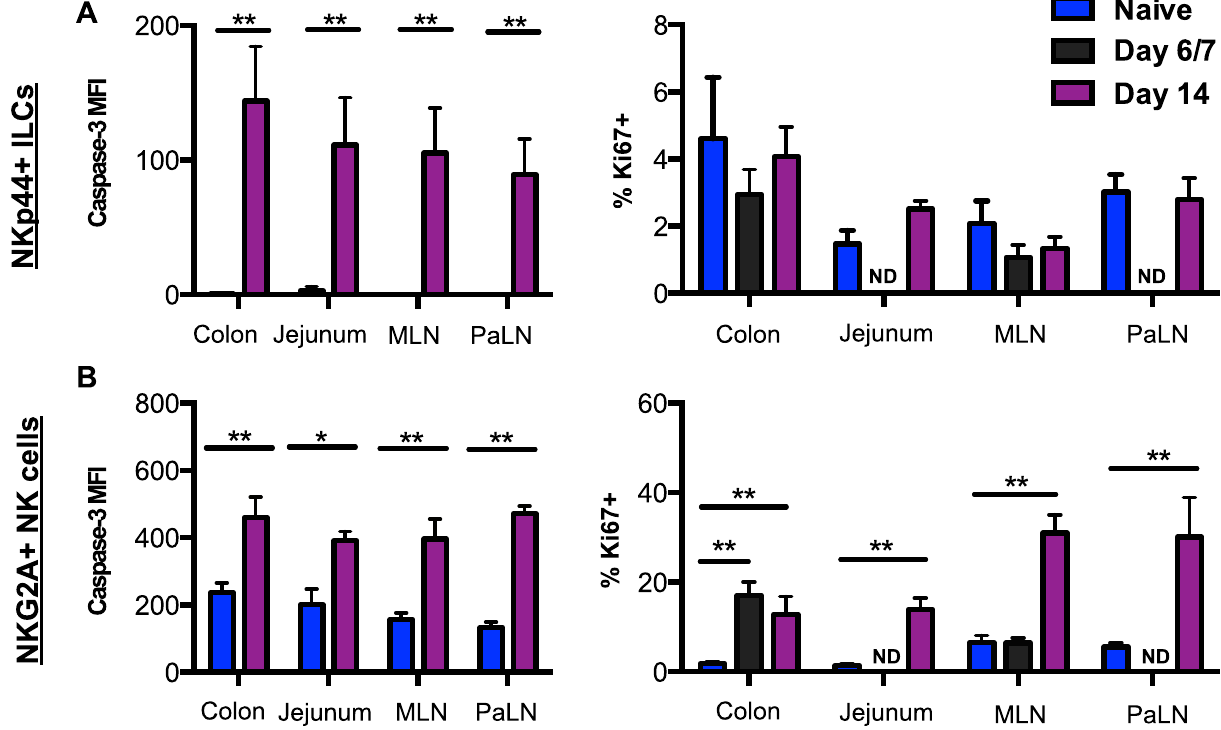
Fig. 3. SIV-induced turnover of NK cells and ILCs in intestinal mucosae. (A) Median fluorescence intensity (MFI) of caspase-3 expression and frequency of Ki67 expression in NKp44 + ILCs from mucosal tissues were compared between naı¨ve and acutely SIV-infected macaques. (B) Expression of caspase-3 and Ki67 in NK cells from mucosal tissues were compared between naı¨ve and acutely SIV-infected macaques. Samples are from naı¨ve macaques (n=6) and those sacrificed at days 6/7 (n=6) or 14 post-infection (n=). Mann-Whitney U test; * p , 0.05, ** p , 0.01. ND, not